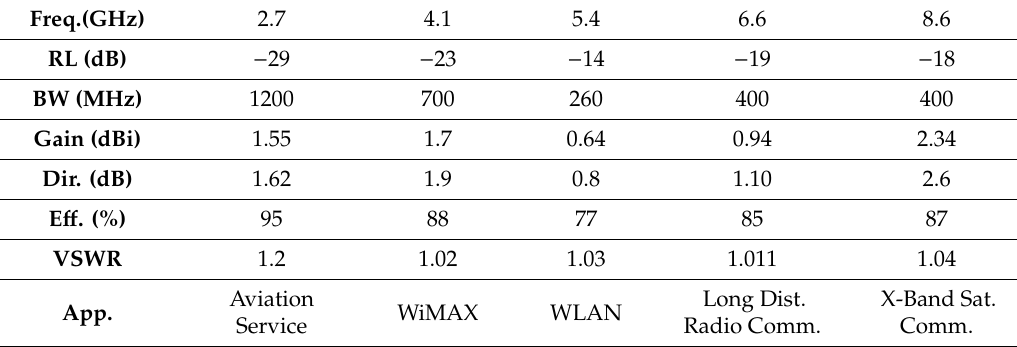
Table 4. Summarized results of Case